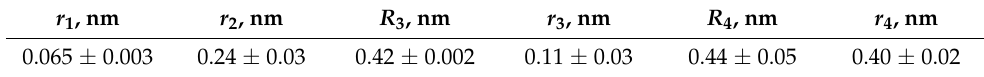
Table 2. Correlation lengths and dispersions in Equation (1).